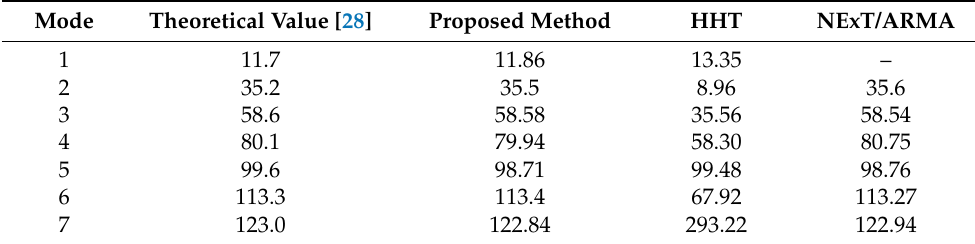
Table 2. Comparison of the modal frequency identification results (Hz).